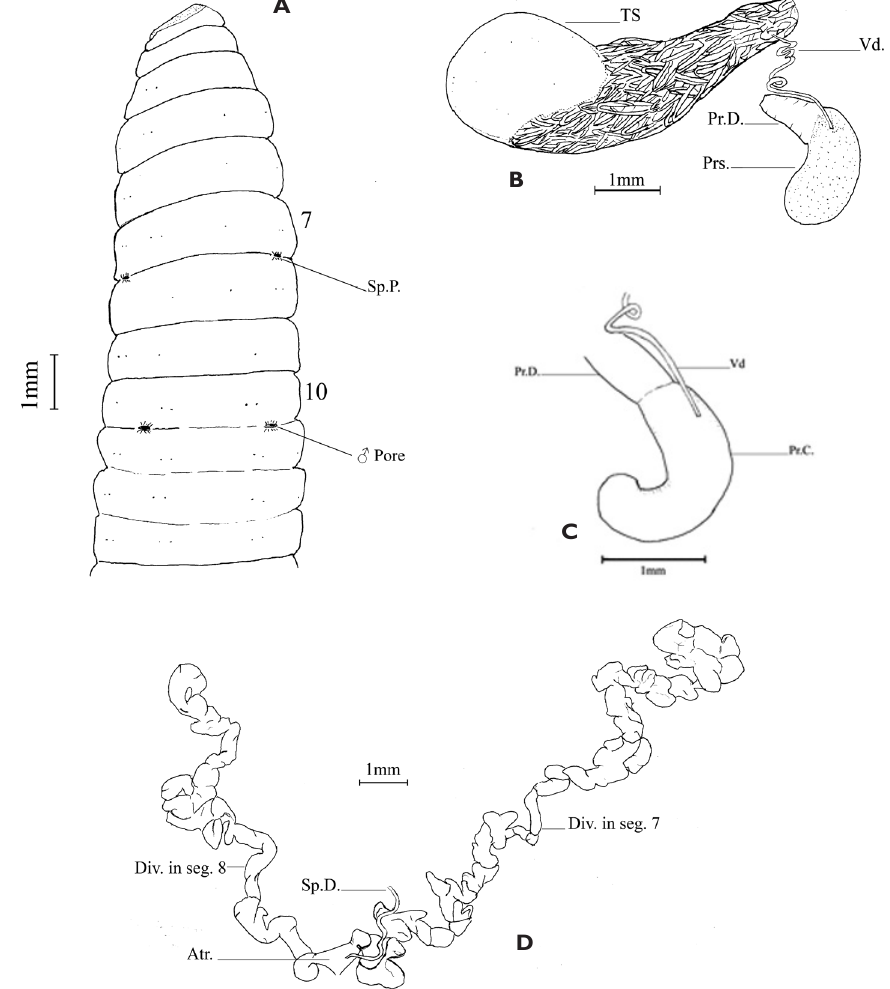
Figure 3. Drawida thomasi sp. n. A Holotype - ventral view B Prostate and testis sac C Prostatic capsule D Spermathecal atria - partially uncoiled. Abbreviations: Atr. – Atrium; Div. in seg. – diverticula in seg- ment; Pr.C. – Prostatic capsule; Prs. – Prostate; Pr.D. – Prostatic duct; Sp.D. – Spermathecal duct; Sp.P. – Spermathecal pore; TS – Testis sac; Vd – Vas deferens. b lines. Genital markings absent. Nephridiopores, present from segment 3, aligned with setae